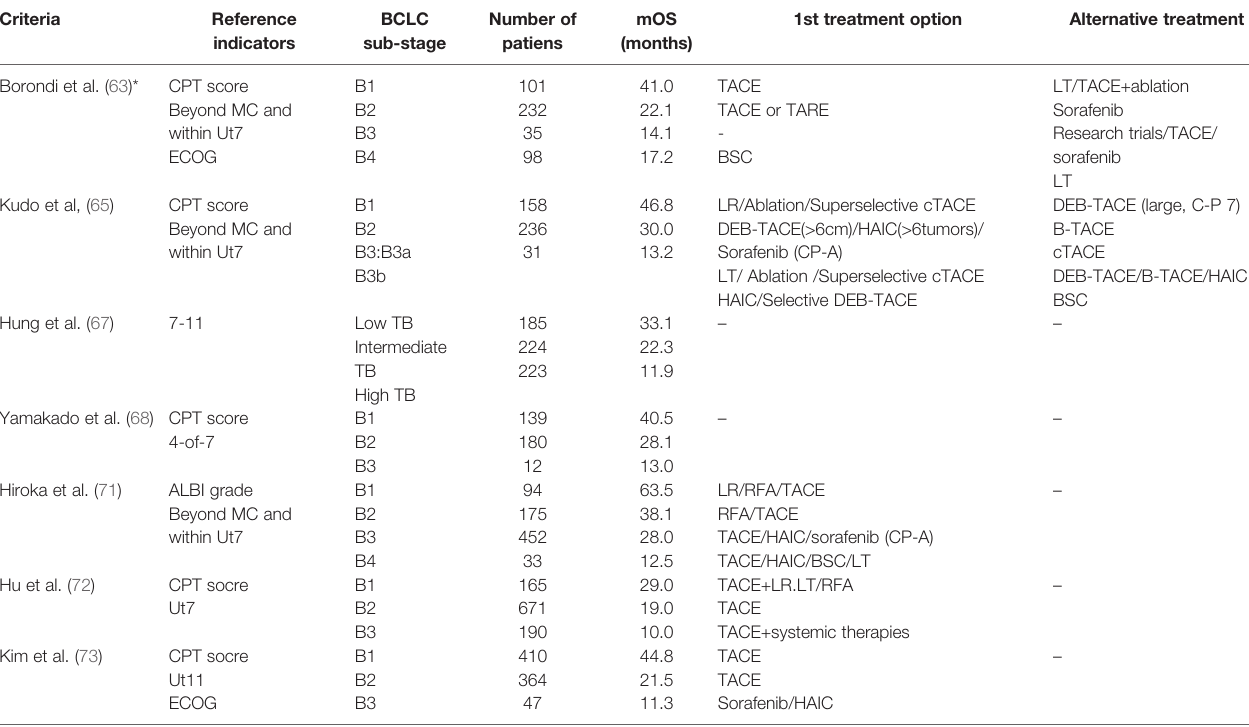
TABLE 1 | Some substaging systems of intermediate stage